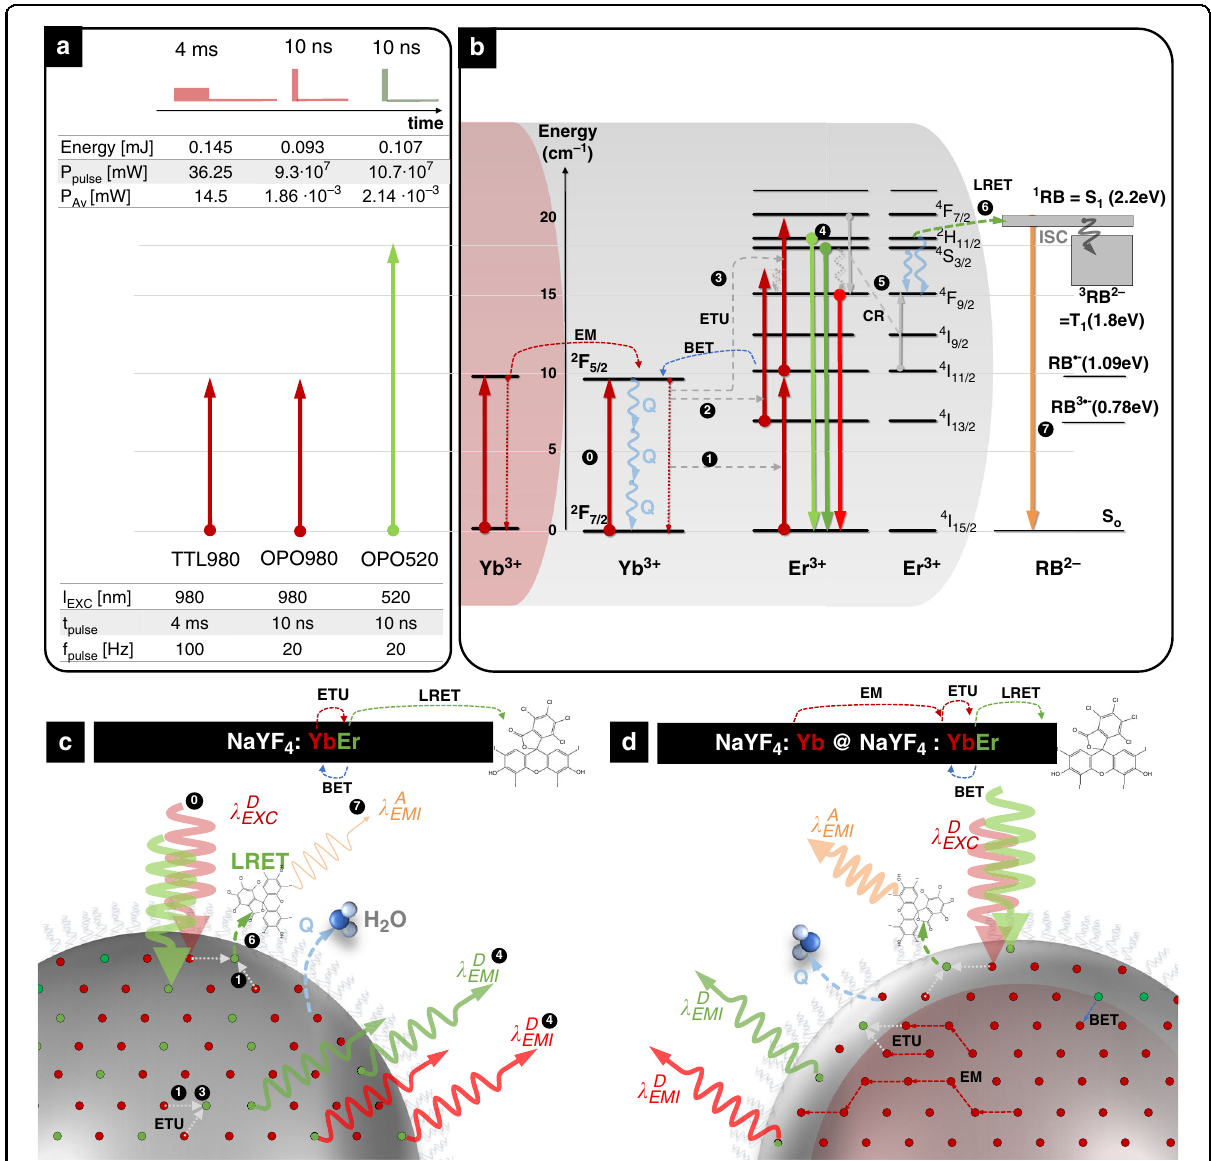
Fig. 1 The excitation schemes and mechanism of UC-LRET between Yb/Er donor NPs and Rose Bengal acceptors. a Three different excitation schemes were used, i.e., (TTL980) 4 ms pulse from CW 980 nm laser diode controlled with TTL, (OPO980) 10 ns pulse of 980 nm from OPO, and (OPO520) 10 ns pulse of 520 nm from OPO. b Energy scheme and transfer in Yb 3 + /Er 3 + — RB system (energy level for RB taken from ref. 49 ); ETU energy transfer upconversion, EM energy migration, BET back energy transfer, ISC inter system crossing, CR cross-relaxation, Q quenching, LRET luminescence resonance energy transfer, schematic presentation of ( c ) YbEr core-only (gray area) UCNP donor nanoparticle compared with ( d ) core (reddish area)-shell (gray area) Yb@YbEr donor NPs, both with RB on the surface. Arrow thickness is qualitatively proportional to the intensity;